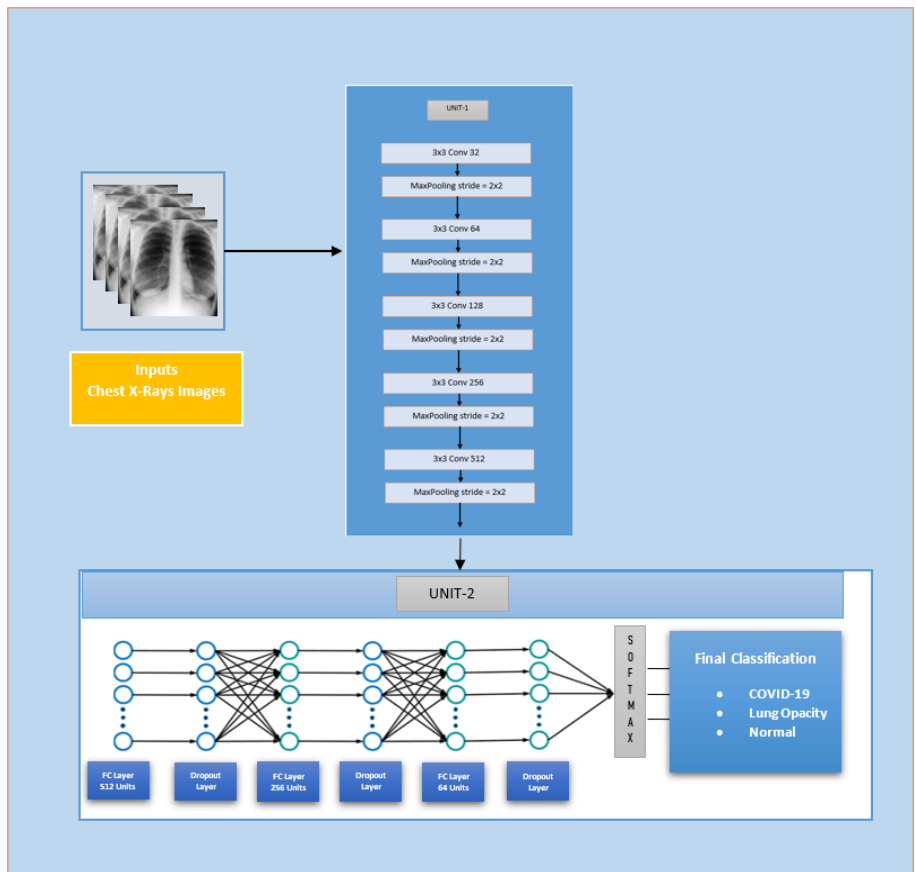
Figure 4. Custom-Model